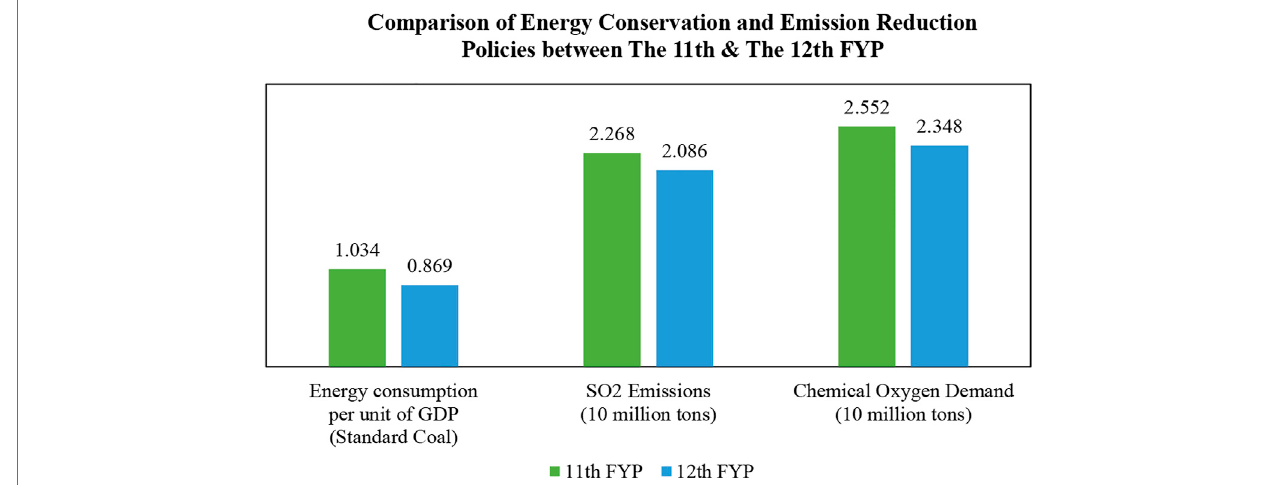
FIGURE 1 | Policy comparison between the 11th and the 12th FYP 2 .